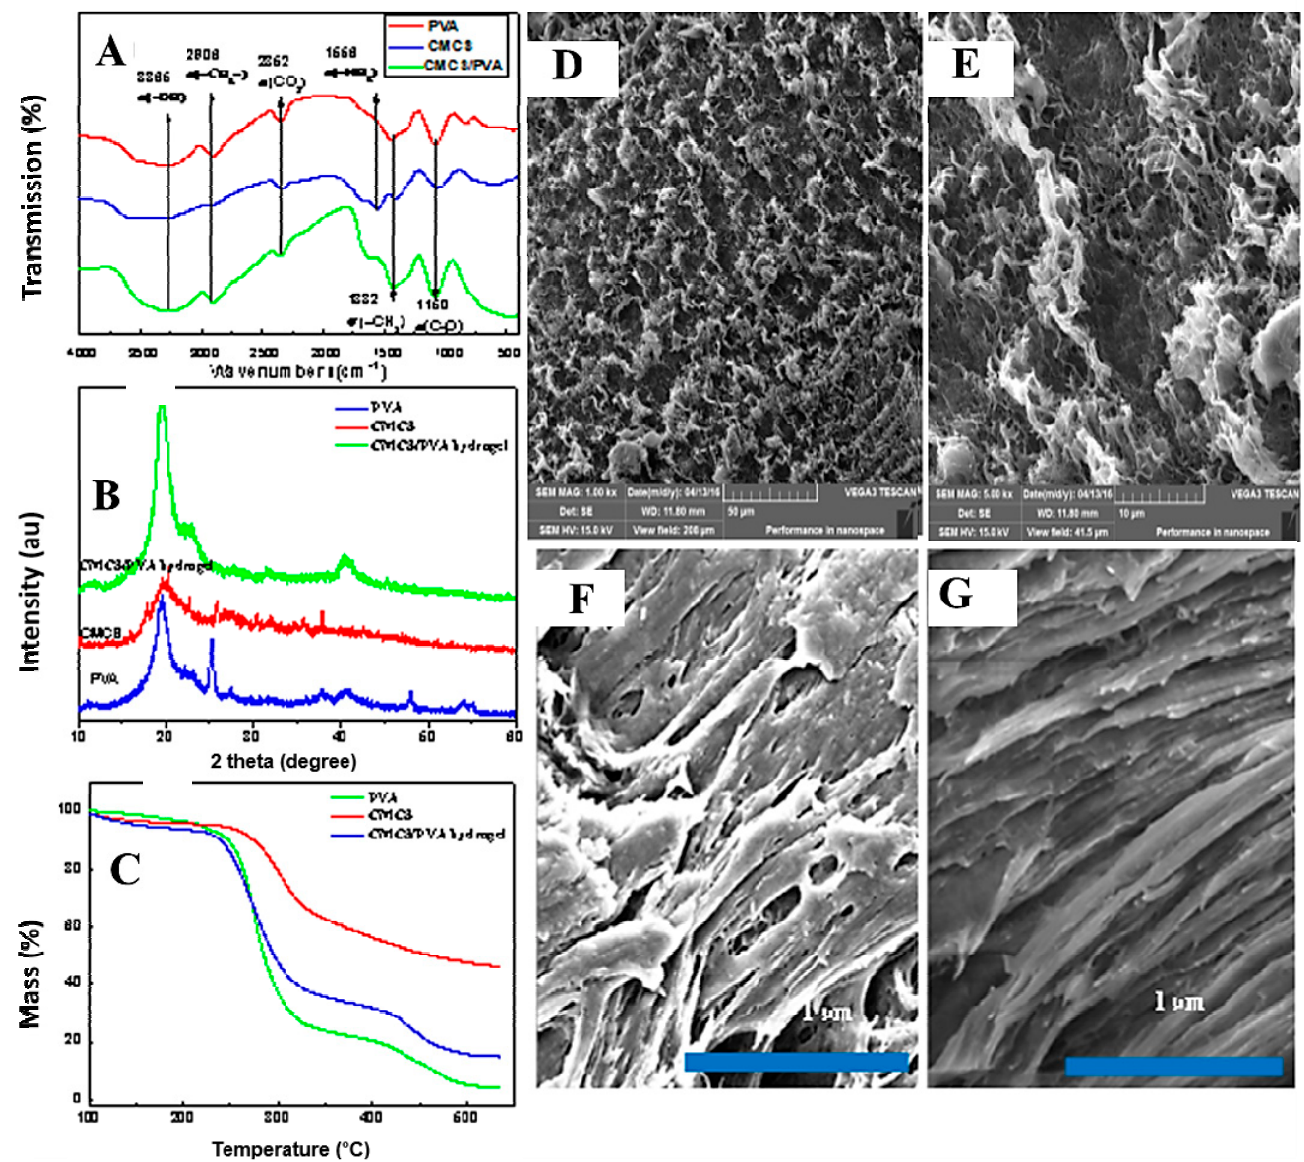
Figure 3. Characterization of the microstructure and morphology of the CMCS/PVA composite hydrogel films. ( A ) FT-IR; ( B ) XRD; ( C ) TG; ( D – G ) SEM.